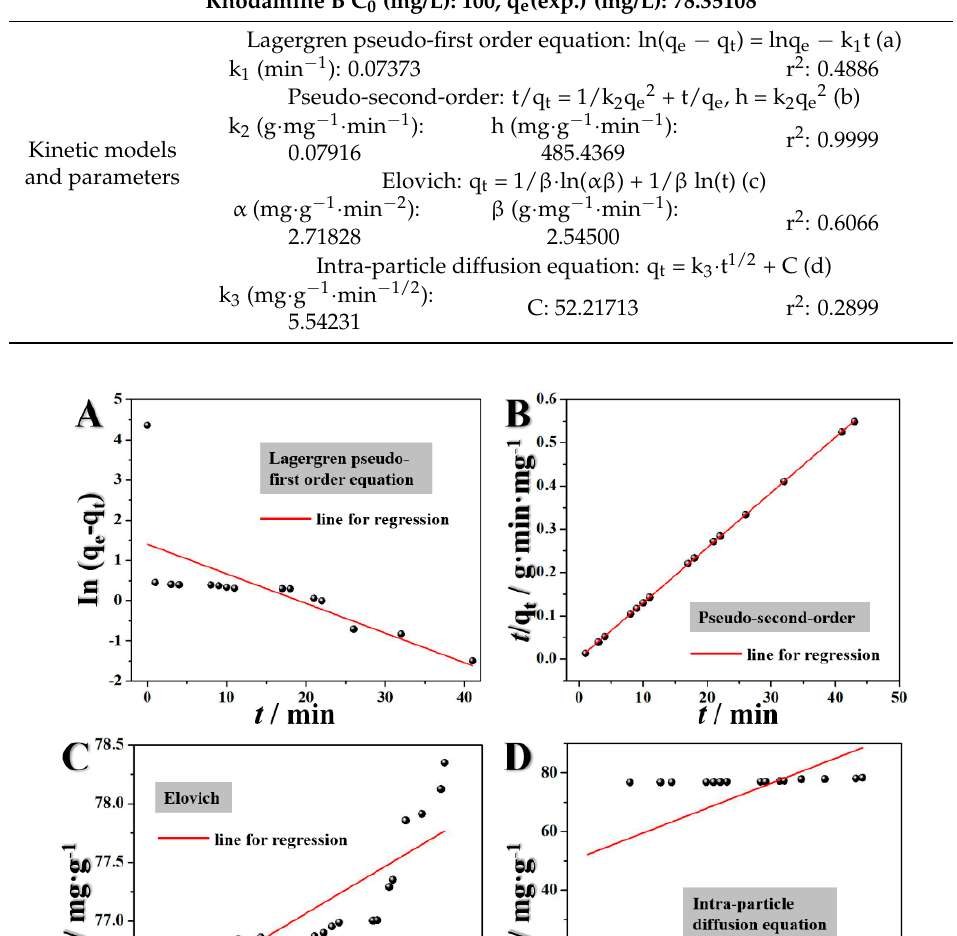
Table 1. Mathematical equations in Rhodamine B adsorption kinetics and kinetic parameters of various models fitted to experimental data.